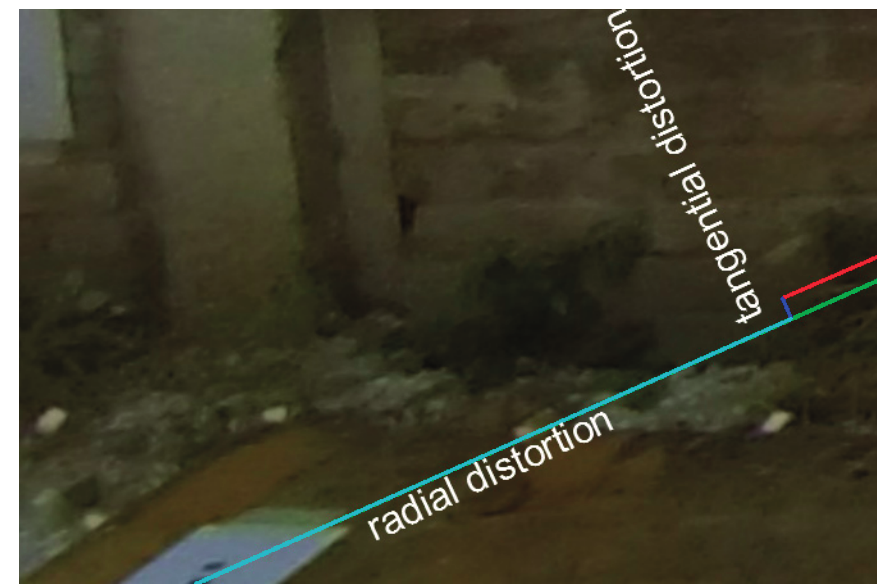
Figure 3. Detail of the